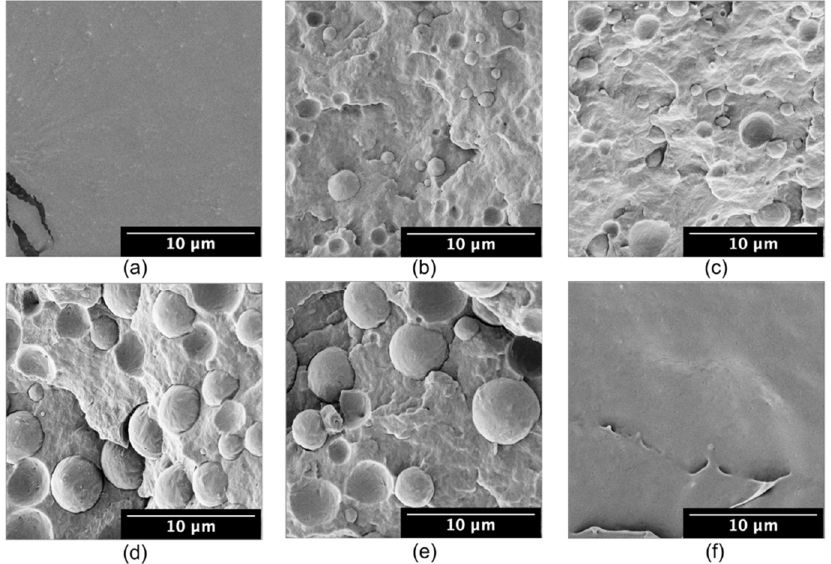
Figure 5. FESEM micrographs of the prepared PA6/PCL blends. ( a ) PA6, ( b ) PA6_5PCL, ( c ) PA6_10 PCL, ( d ) PA6_20PCL, ( e ) PA6_30PCL, ( f ) PCL.